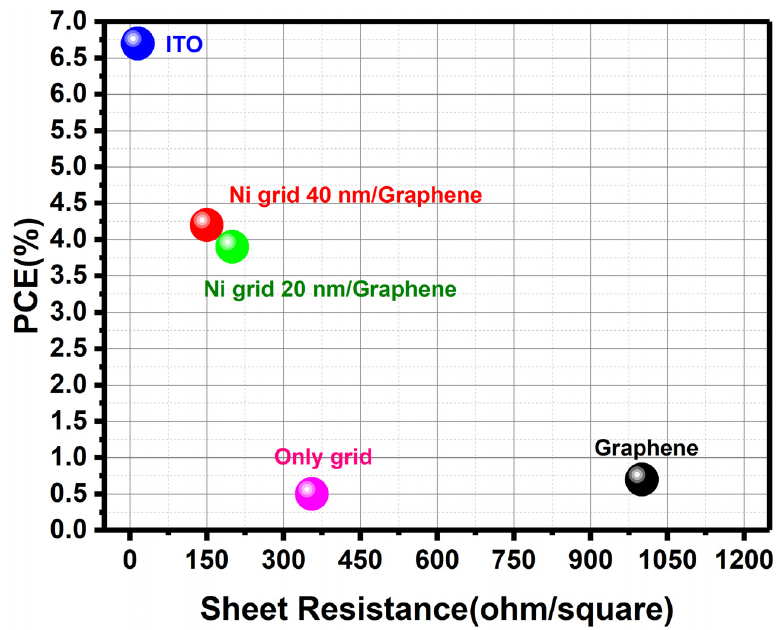
Figure 7. Summary of the best performance obtained with the organic solar cells realized with the different type of transparent conductive electrodes reported in this work.